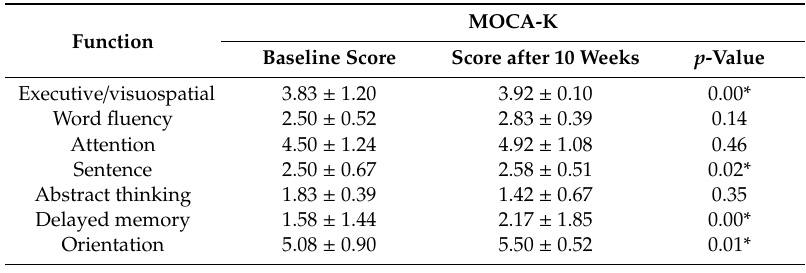
Table 3. Sub-item analysis of MOCA-K scores in the intervention